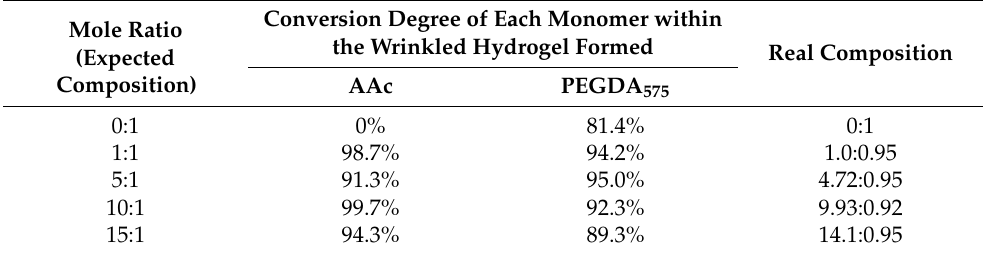
Table 2. Real composition of net-poly (AAc- co -PEGDA 575